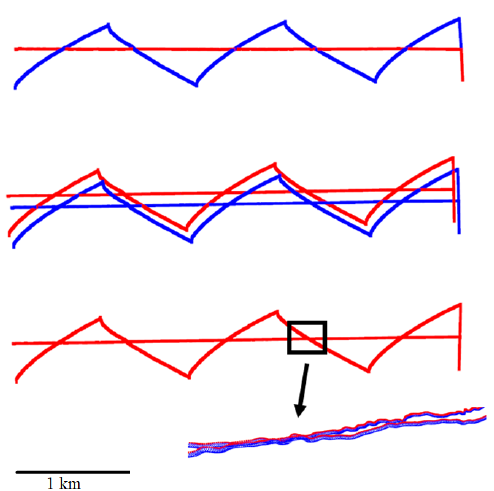
Figure 8: Validations scenarios in real-world experiments. (Top) The data are partitioned into two patches, a zig-zag path, and a straight path; (Middle) The data are partitioned into left and right images of the stereo-pair. Note that, the offset between the two lines is enlarged for a better illustration; (Bottom) Full dataset with a side view magnification at the intersection be- tween the zig-zag and straight